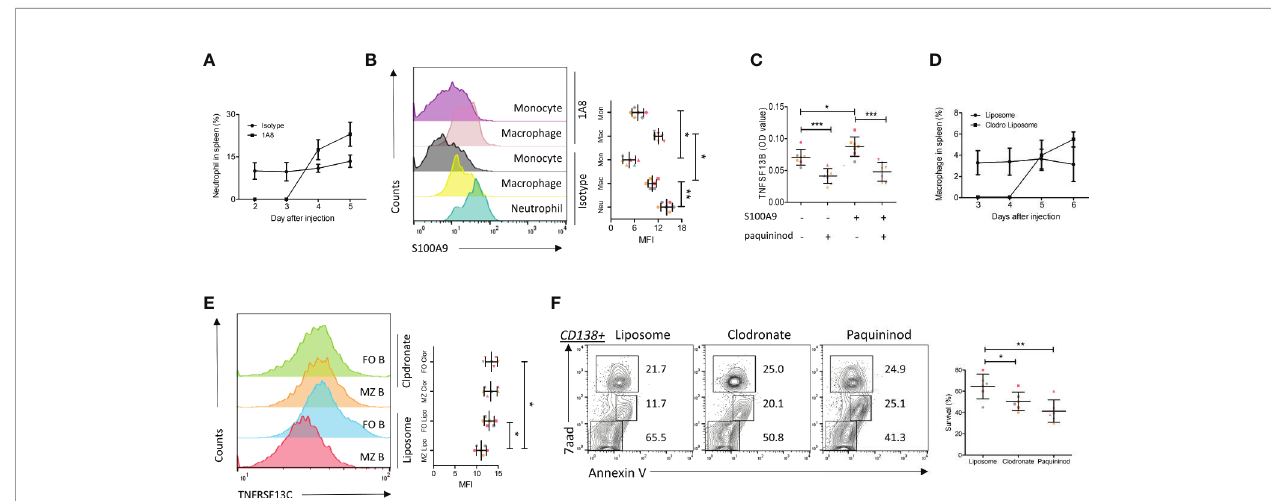
FIGURE 3 | S100A9 and TNFSF13B contribute to the survival of plasma cell. (A) Neutrophils were depleted by injecting 1A8 monoclonal antibody. At the indicated time points, the proportion of CD45 + Ly6G high neutrophils in the spleen was measured by means of fl ow cytometry. (B) Flow cytometry histograms reveal the surface presence of S100A9 of splenic neutrophil, macrophage, and monocyte before and after neutrophil depletion. The data shown in the dot plot indicate the means ± SD of six mice from three independent experiments. (C) Isolated human monocytes were treated with S100A9 and/or paquininod, while the levels of TNFSF13B were measured 24 h after treatment. The data shown in the dot plot are the means ± SD of seven samples from three independent experiments. (D) Macrophages were depleted by injecting Liposomal Clodronate. At the indicated time points, the proportion of CD45 + F4/80 + macrophages in the spleen was measured via fl ow cytometry. The data shown in the dot plot are the means ± SD of six mice from two independent experiments. (E) Flow cytometry histograms demonstrate the surface presence of TNFRSF13C of splenic MZ and FO B cell after macrophage depletion. (F) FACS plots indicate the proportion of 7aad + dead and Annexin V + apoptotic cells in the splenic CD138 + cells. The data shown in the dot plot are the means ± SD of six mice from three independent experiments. All data were analyzed through Student ’ s t- tests; *P < 0.05, **P < 0.01; ***P <